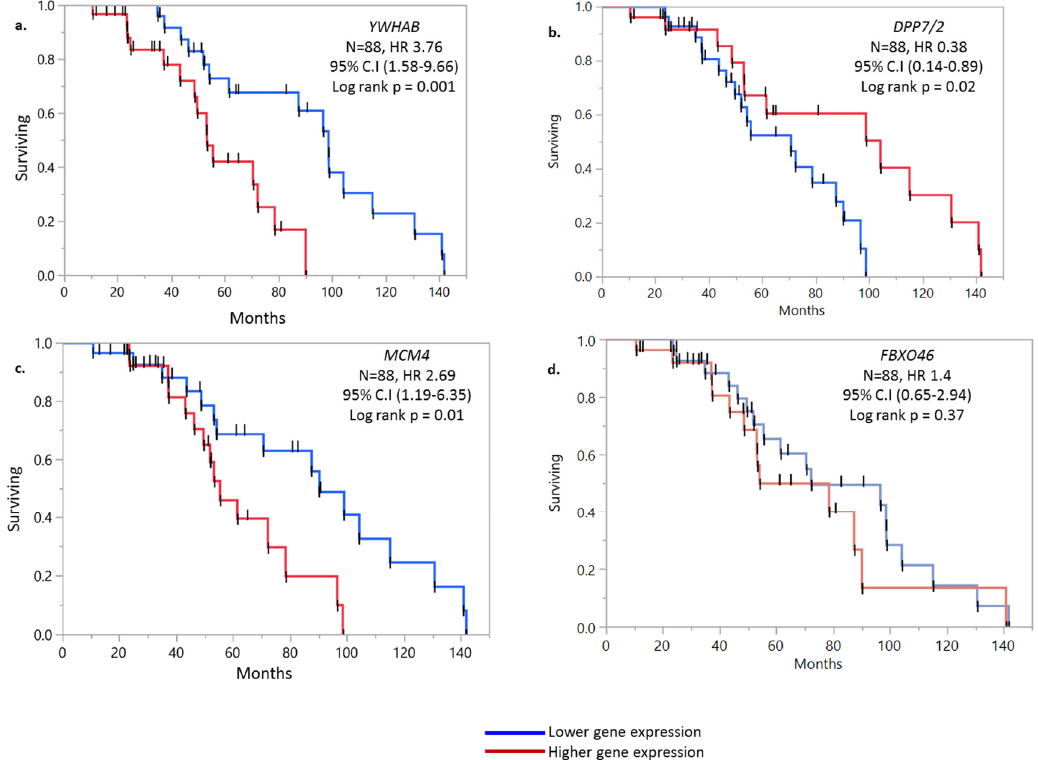
Figure 1. Kaplan-Meier curve of ( a ) YWHAB , ( b ) DPP7/2, ( c ) MCM4 , ( d ) FBXO46 from clinical dataset that were included in generation of prognostic score based on Cox proportion hazard model. The patients were divided into 2 groups, higher and lower based on median gene expression as a cut-off point.